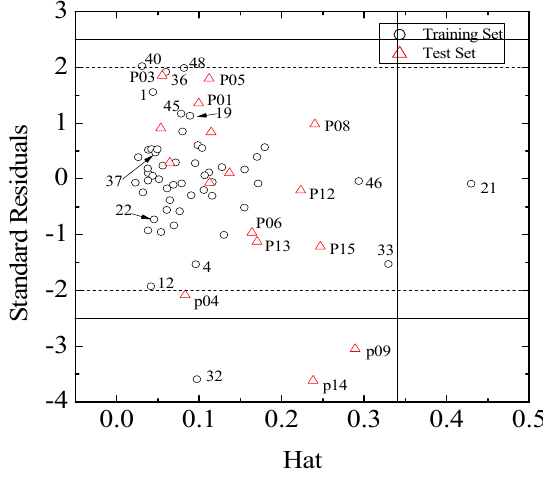
Figure 3. Williams plot for the training and test